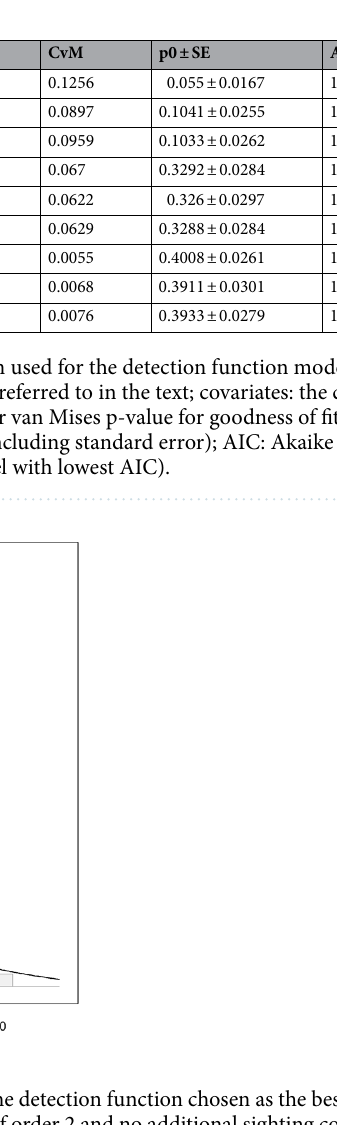
Figure 5. Fin whale feeding aggregation at a distance. The horizon is covered by blows of a feeding aggregation numbering approximately 150 fin whales. ©BBC (OSM video 4).